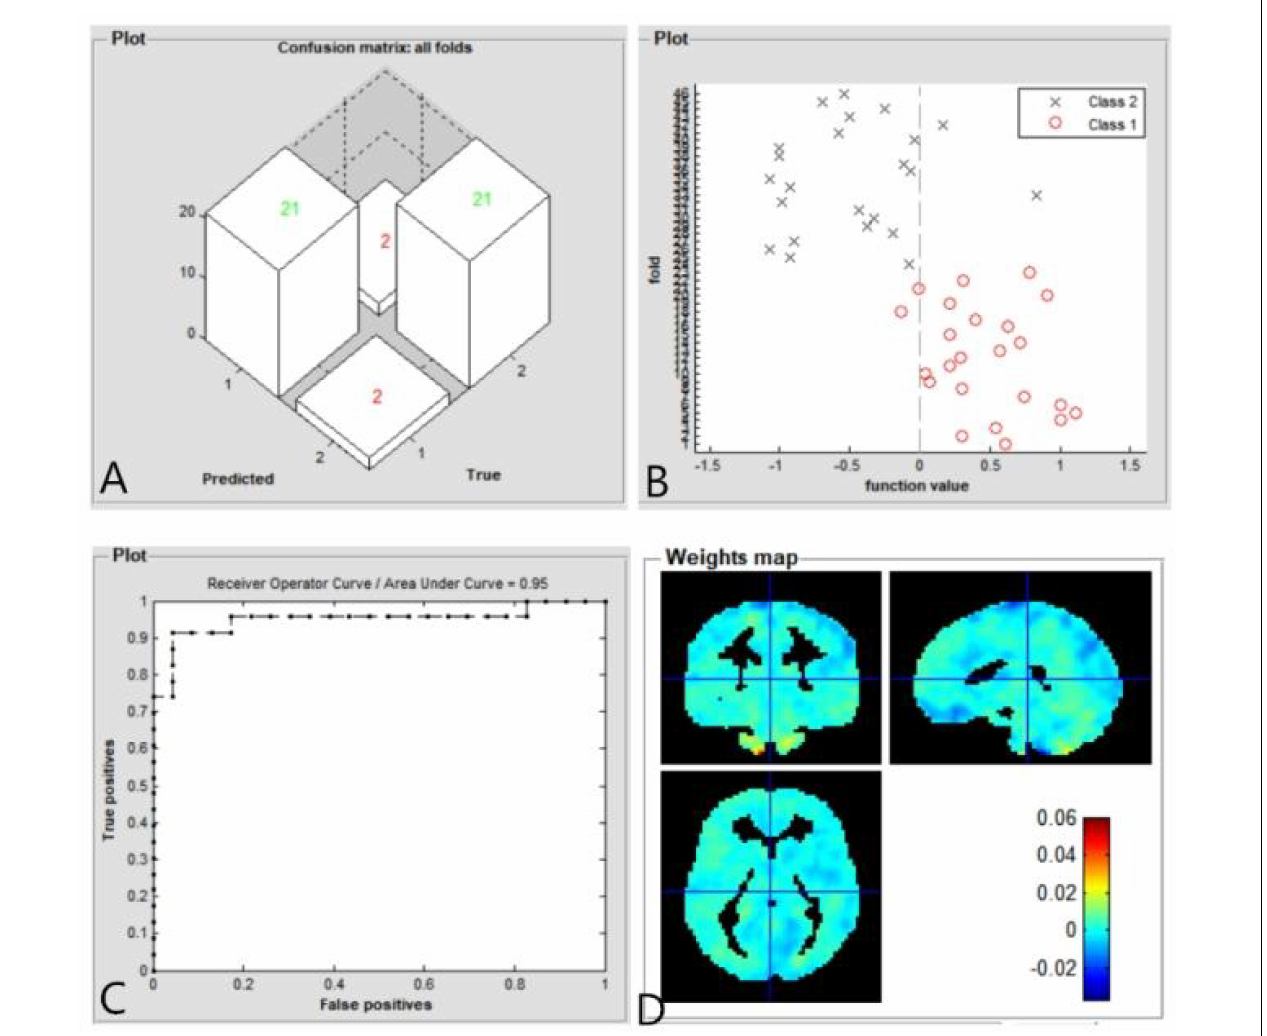
FIGURE 4 | Classification results using machine learning analysis based on ReHo values. Three-dimensional confusion matrices from machine learning analysis (A) . Function values of two groups (class 1: PACG group; class 2: HC group) (B) . The ROC curve of the SVM classifier with an AUC value of 0.95 (C) . Weight maps for SVM models. The weight in each voxel corresponding to its contribution to the model’s prediction (D)